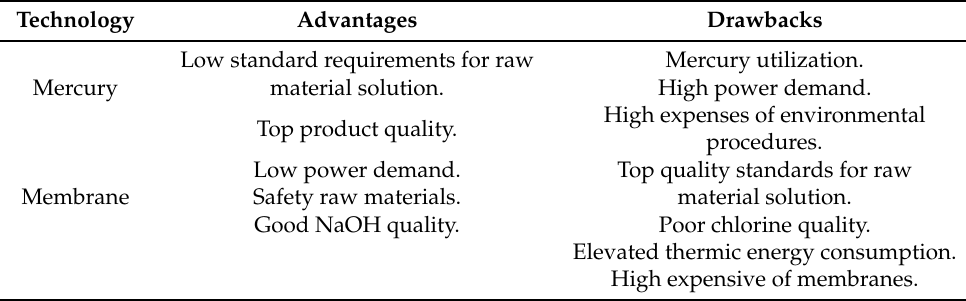
Table 1. Advantages and drawbacks of electrolytic chlor-alkali